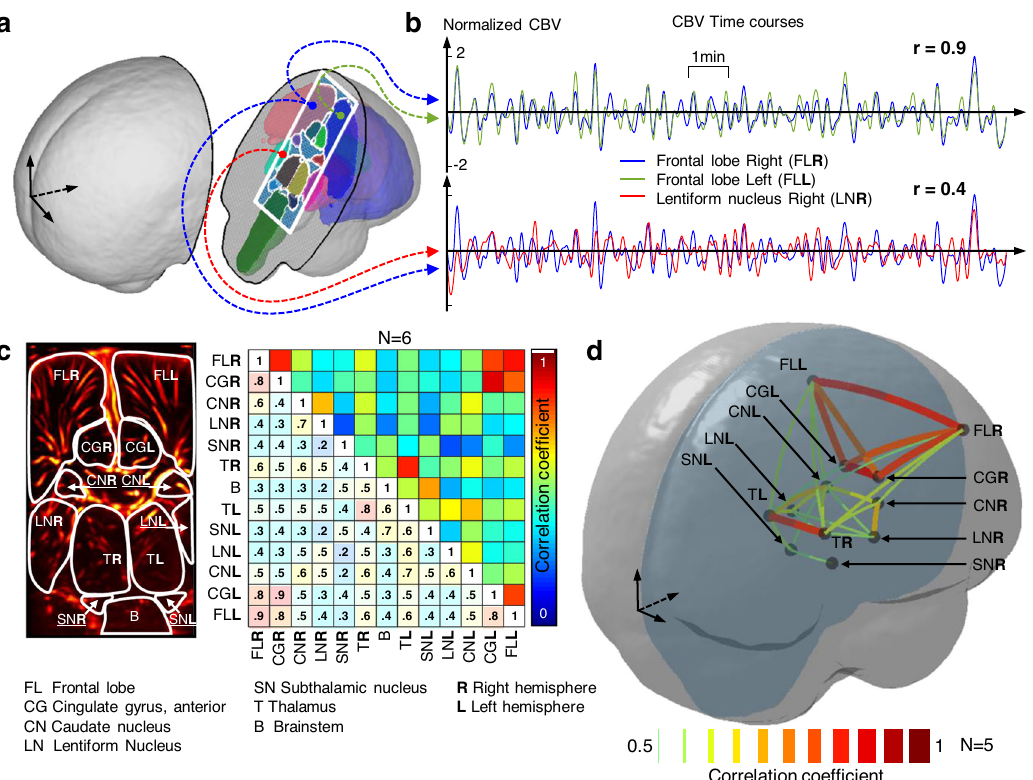
Fig. 2 fUS reveals the intra- and interhemispheric connectivity in very preterm neonates. ( CBV cerebral blood volume). a Schematic view of the ultrasound plane of interest (white rectangle) registered on MRI atlas. b Example of normalized 10-min long CBV time courses obtained with fUS and averaged over three cerebral areas. The Pearson correlation coef fi cients r are computed between the signals. r = 0.9 for FLR vs FLL, r = 0.4 for FLR vs LNR. c Markropoulos atlas (white boundaries) overlaid on a doppler image in the plane of interest. The CBV is averaged in each zone and the correlation coef fi cients are computed for every pair of CBV time courses (see panel b for an example), leading to the adjacent connectivity matrix. This matrix is obtained by averaging the results over N = 6 very preterm infants born at 28 ± 2 weeks gestation and imaged at postnatal day 9 ± 3. d “ Connectome" represented as links between different cerebral regions ’ centroids according to correlation coef fi cients. Source data are provided as a Source Data fi